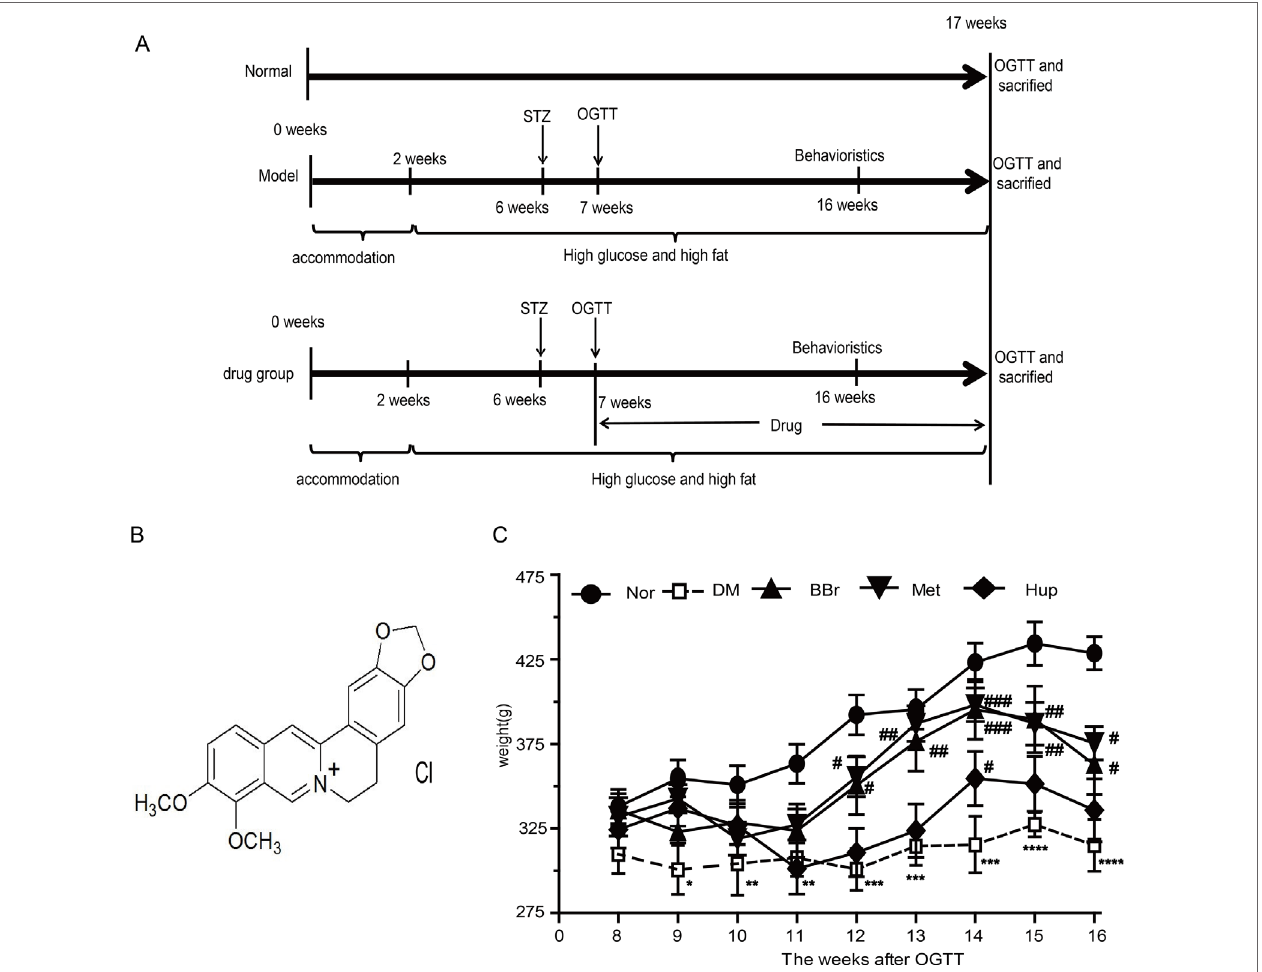
FIGURE 1 | Flow chart of animal experiment design and body weight variation. (A) A total of 100 male Wistar rats fed with HSFD diet were assigned to DM model groups, whereas 20 rats fed by standard chow were assigned to control group. After 2 weeks adaptive feeding, DM model group was given HSFD feeding for 4 weeks. Then, 25 mg/kg STZ was injected into caudal vein to form the diabetes animal model in HSFD group, whereas normal group were injected with citrate buffer only. Behavioral evaluation was performed after feeding for 16 weeks. In the 16th week, all rats were sacrificed from which we collected samples and executed follow-up experiment. (B) Molecular formula of berberine. (C) Body weight variation. * P < 0.05 vs. Nor; ** P < 0.01 vs. Nor; *** P < 0.001 vs. Nor; **** P < 0.0001 vs. Nor; # P < 0.05 vs. DM; ## P < 0.01 vs. DM; ### P < 0.01 vs.